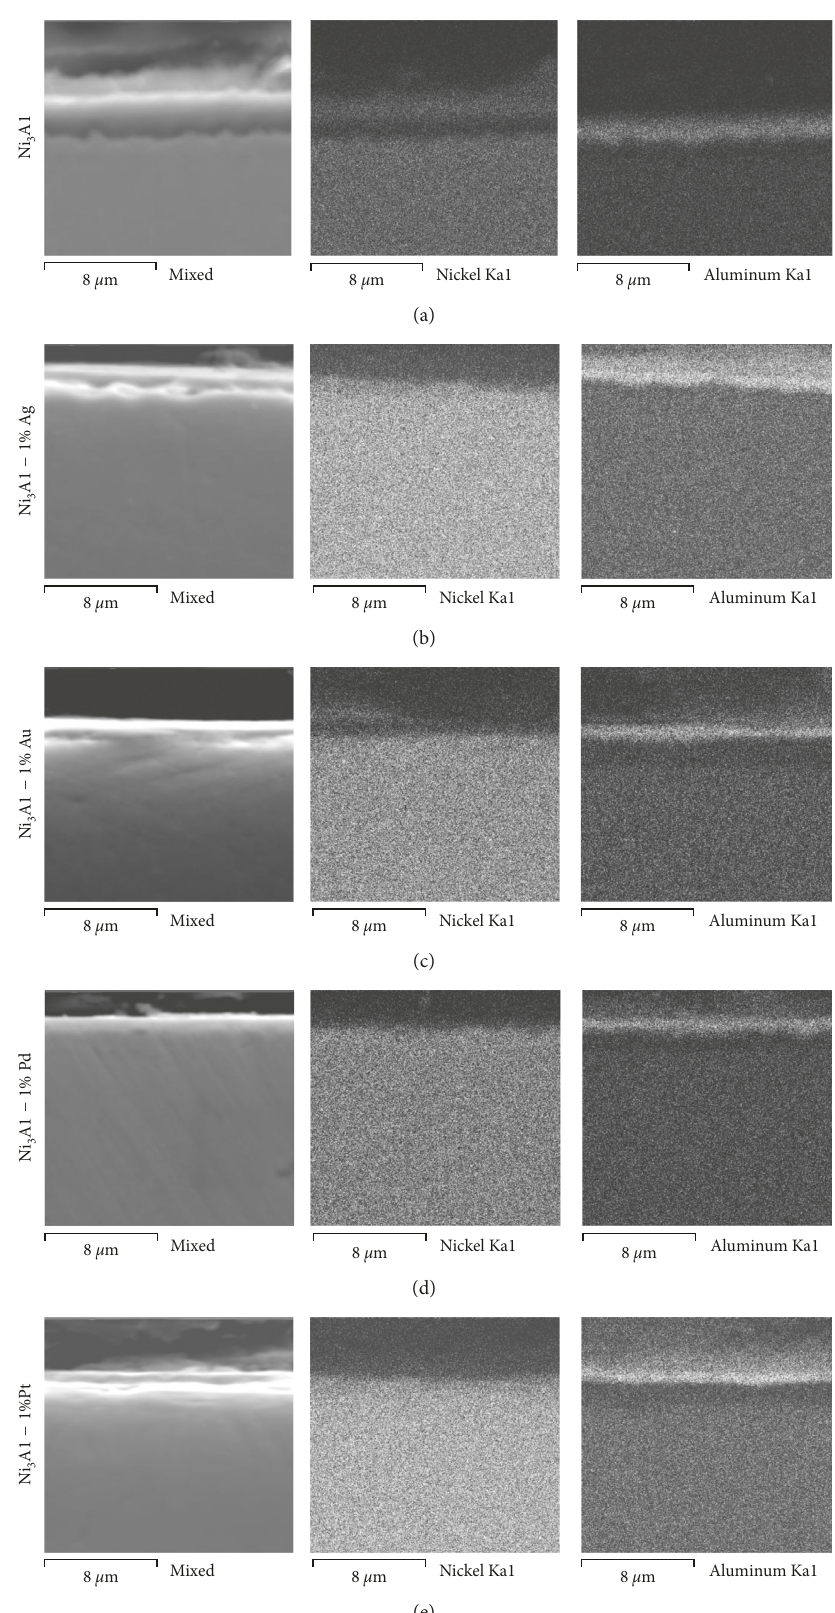
(e) 3 Al, (b) Ag-doped alloy, (c) Au-doped